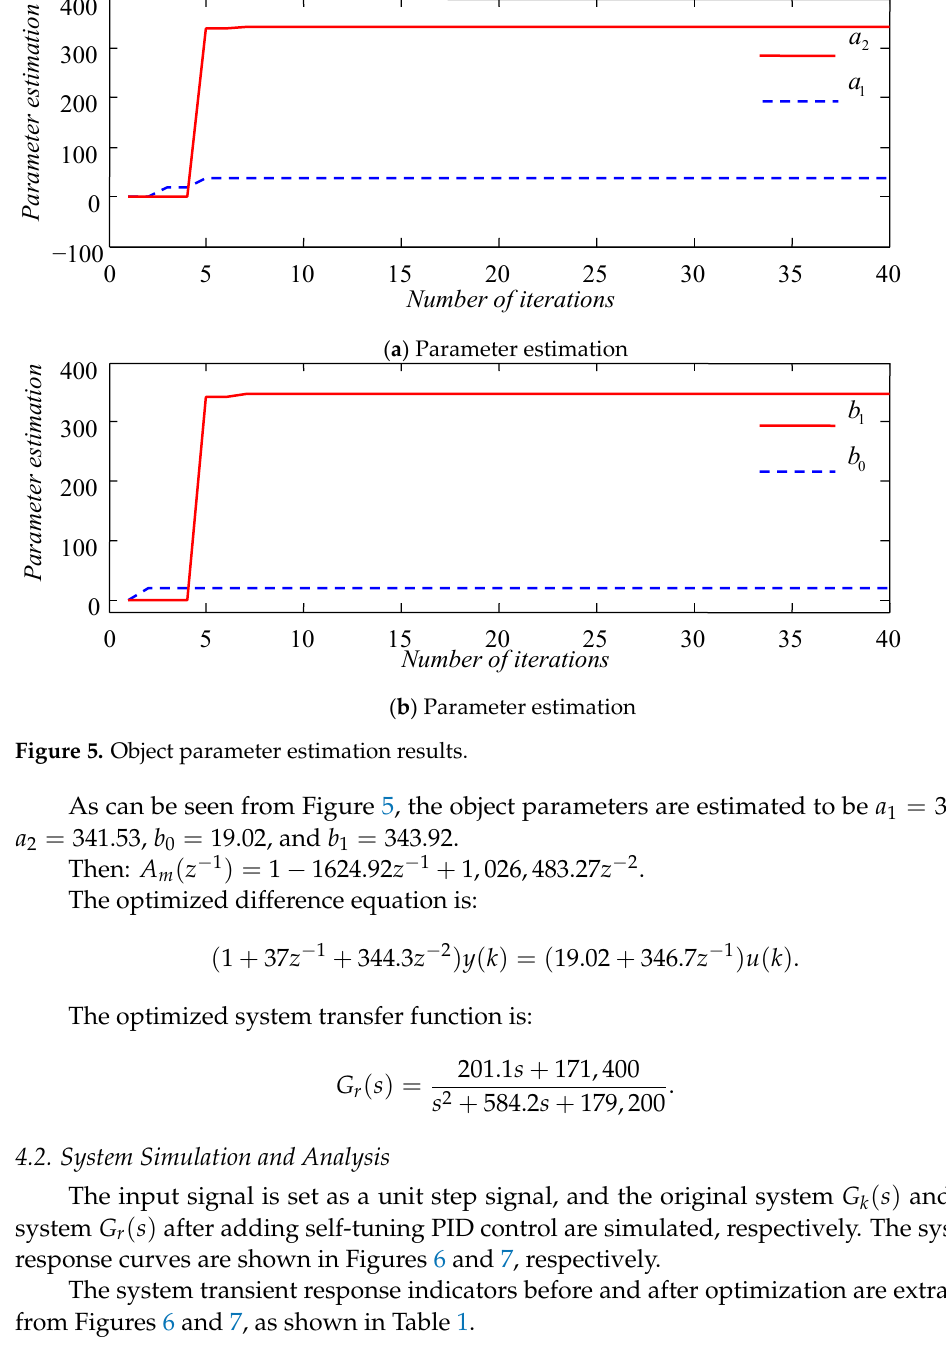
Table 1. Transient response indexes of original system and optimized